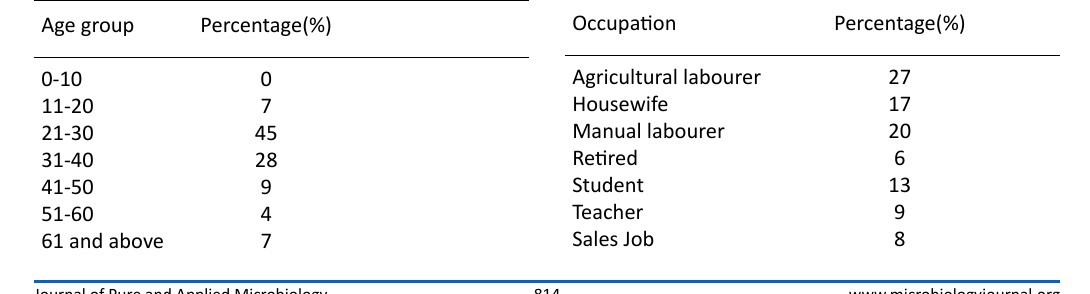
Table 2. Age-wise distribution of study population Age group